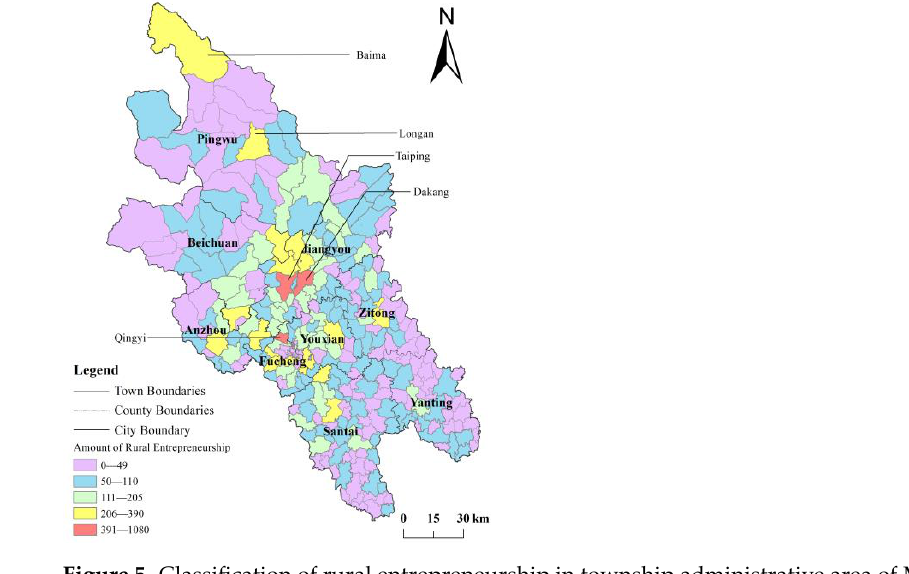
Figure 5. Classification of rural entrepreneurship in township administrative area of Mianyang.